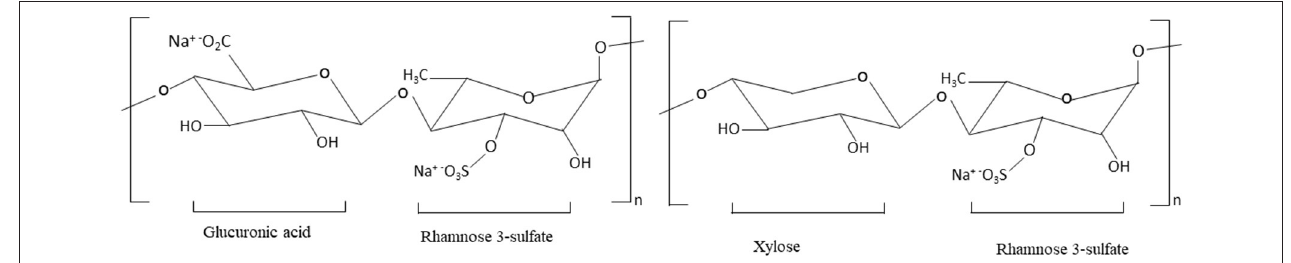
FIGURE 2 | The structure of E. prolifera polysaccharide. This polysaccharide is composed of monosaccharides: rhamnose, glucuronic acid, and xylose that are linked by β (1–4) glycosidic bonds. The C-3 position of rhamnose contains a negatively charged sulfate